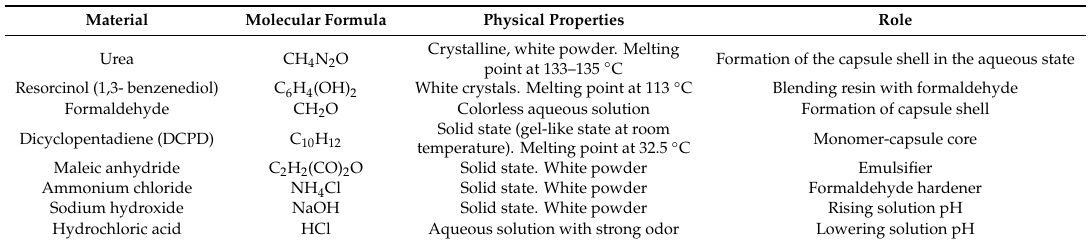
Table 2. Chemical substances used in the production of poly-urea-formaldehyde (PUF) microcapsules with embedded dicyclopentadiene